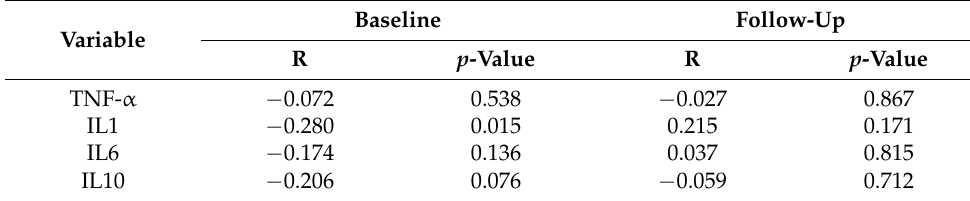
Table 5. Correlation of selected cytokine with baseline and follow-up 25OHD levels.